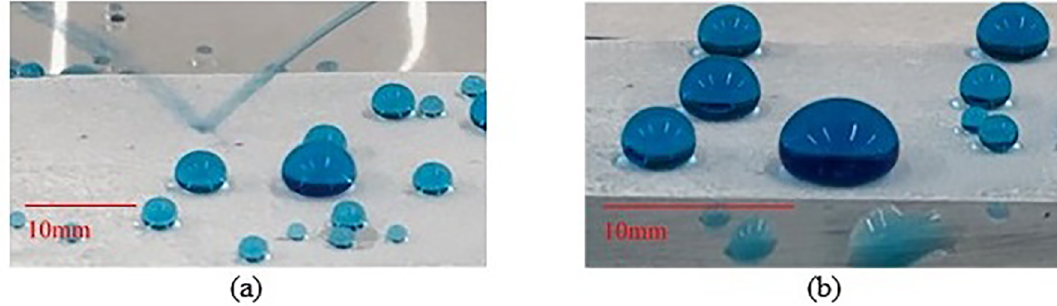
Figure 7. Optical photograph of (a) water jet bouncing on the superhydrophobic modified substrate, (b) water drops on the superhydrophobic modified substrate after water jet bouncing.